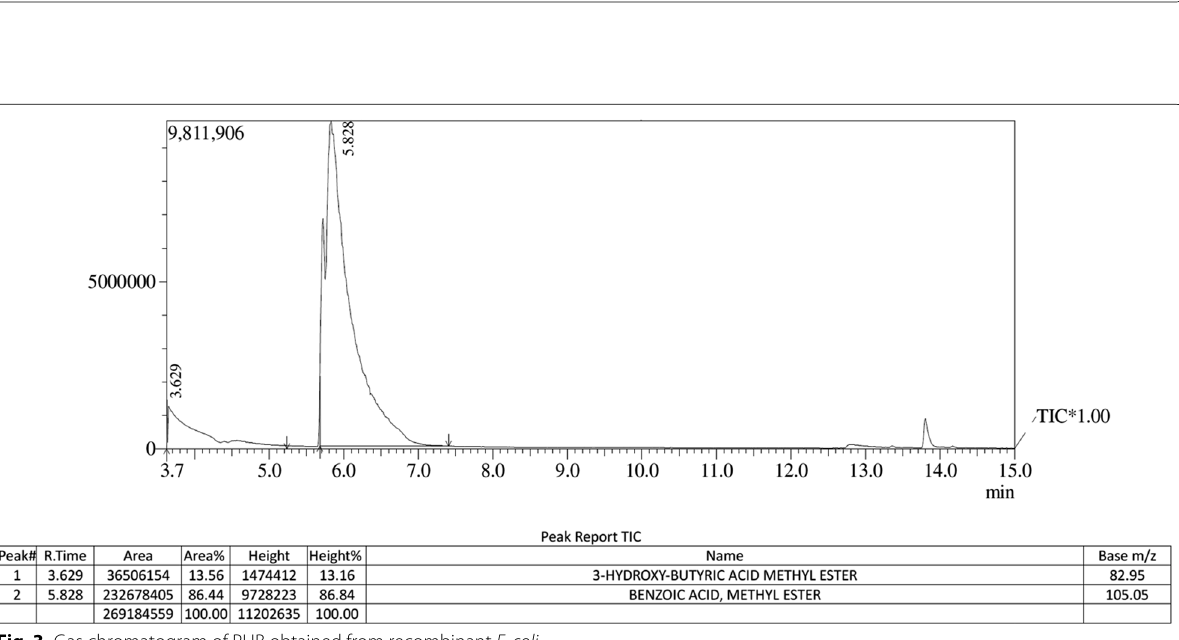
Fig. 2 Visualization of polymer accumulation in recombinant E. coli . A Cells stained with Sudan Black B observed through light microscope. B Confocal microscopic images of cells stained with Nile Red ( 50 magnification). C TEM images of cells with PHB granules (magnified view in the × circle, scale bar